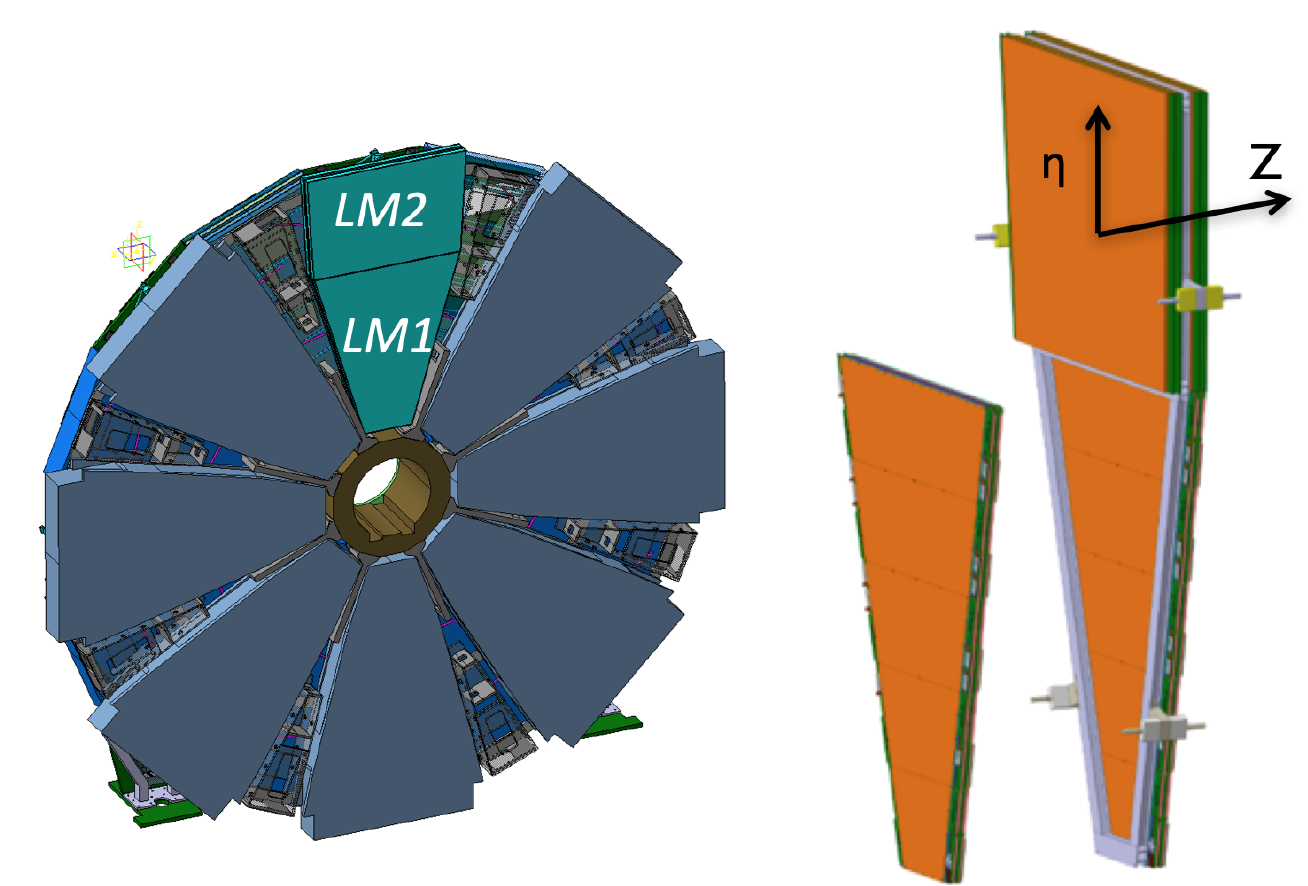
Figure 10. NSW layout with eight large sectors on the HO side ( left ) and detail of Micromegas module stacking in one sector ( right